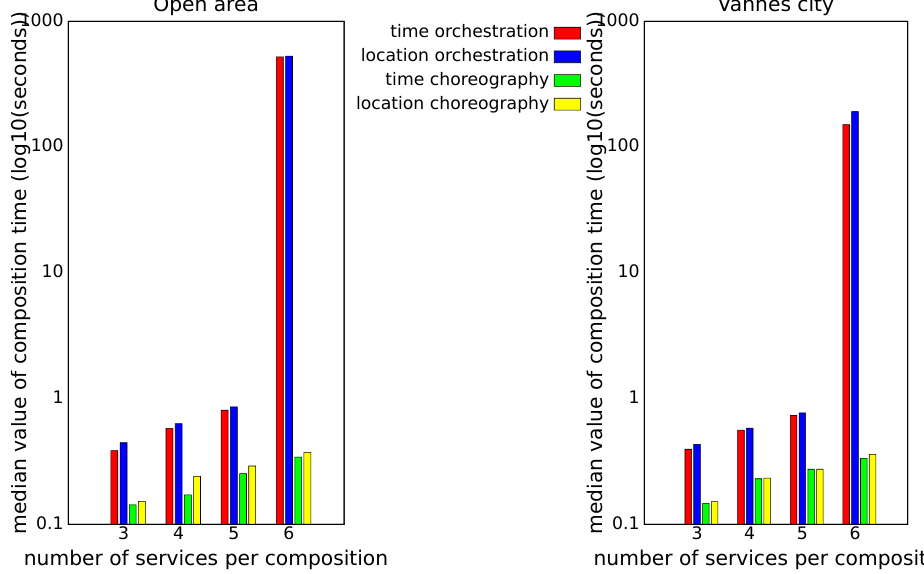
Figure 8. Median of invocation time against the number of services per